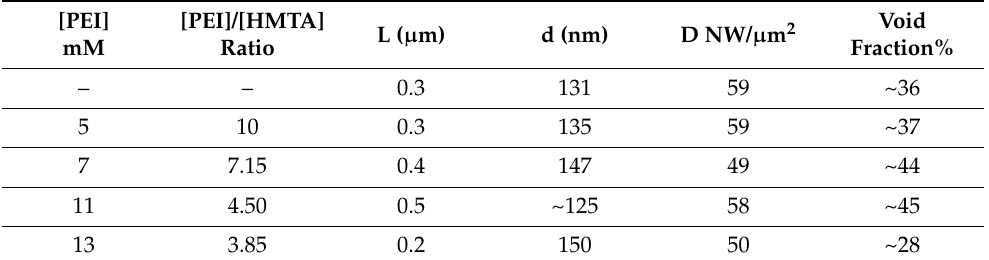
Table 3. Evolution of the length, diameter, apparent density, and void fraction of ZnO NWs as a function of the [PEI]/[HMTA] ratio. The concentration of the Zn(NO 3 ) 2 solution is fixed at 50 mM, and the growing time and temperature are respectively 6 h and 90 ◦ C. [PEI] [PEI]/[HMTA] mM